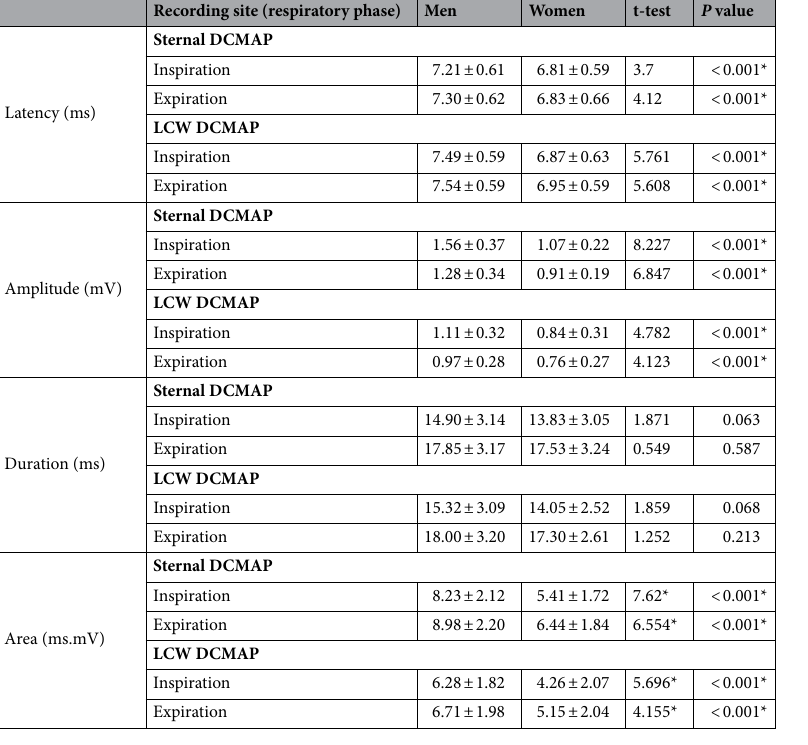
Table 3. Comparison between DCMAPs recorded in men and women (n = 70). *Statistically significant at p ≤